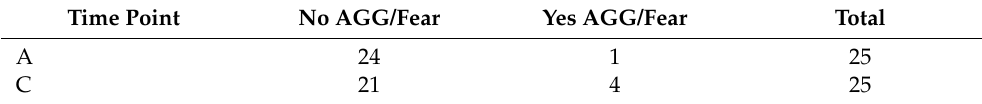
Table 6. Number of foster cats displaying aggressive/fearful behavior at time points A and